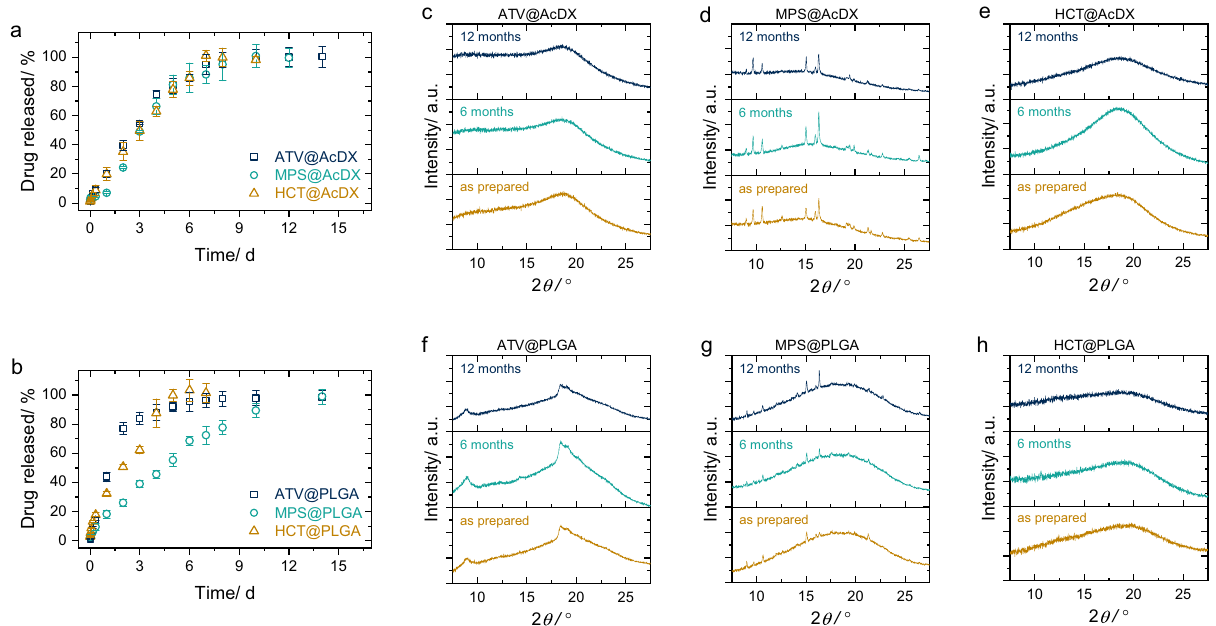
Fig. 4 Release pro fi les and stability of the prepared microspheres. a , b Release pro fi les of ATV, MPS, or HCT from AcDX ( a ) or PLGA ( b ) microspheres ( n = 3). Data are presented as mean values± SD. c – e X-ray powder diffractogram of drug-loaded AcDX microspheres, ATV@AcDX ( c ), MPS@AcDX ( d ) and HCT@AcDX ( e ), stored at 25 °C/40% relative humidity for 6 and 12 months. f – h X-ray powder diffractogram of drug-loaded PLGA